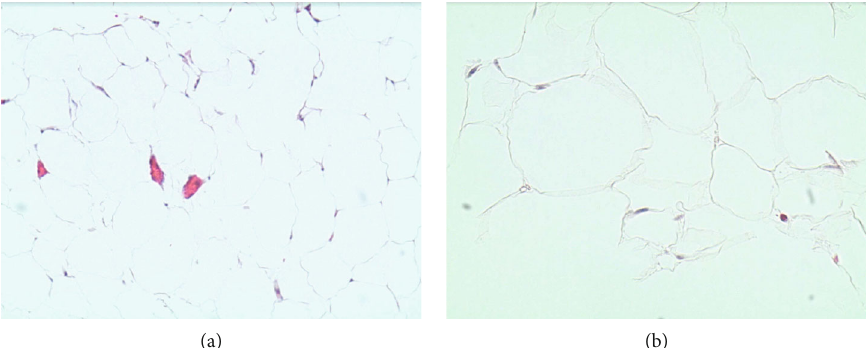
Figure 6: Pericardial lipoma biopsy on low power (a) and high power 40x (b). Findings: benign adipocytes consistent with lipoma. Negative for malignancy.